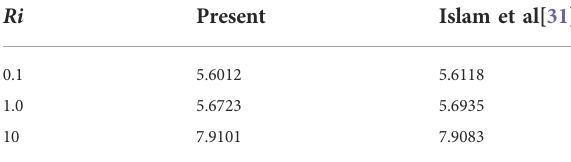
TABLE 3 Code validation for con fi guration with an obstacle. Ri